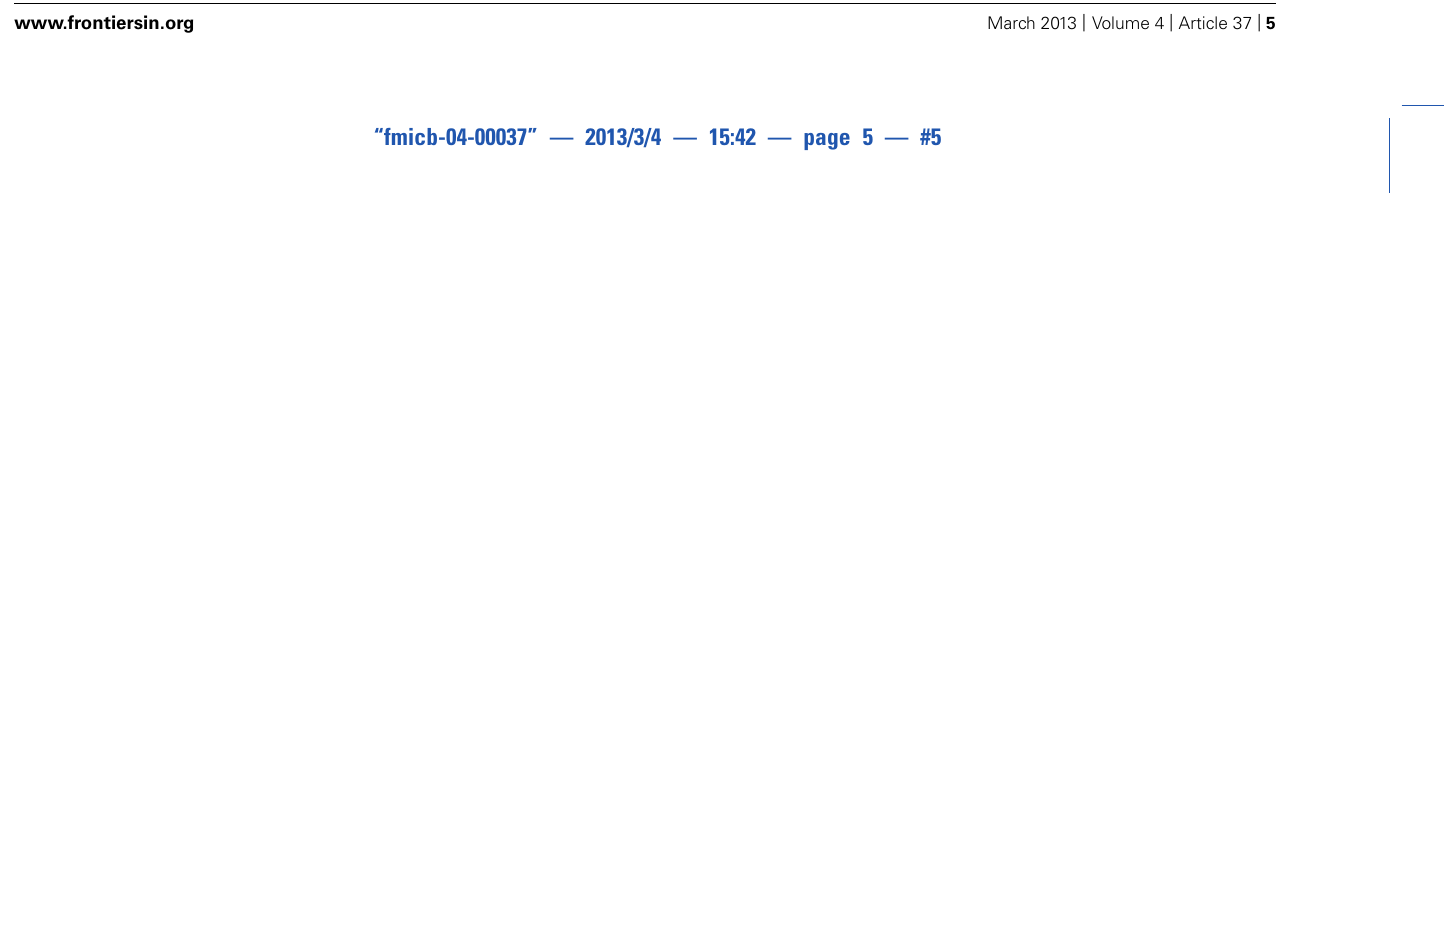
Accession numbers of sequences retrieved from GenBank are given between brackets. Only bootstrap values higher than 50% are given at nodes.The scale bar represents the number of substitutions per a unit branch